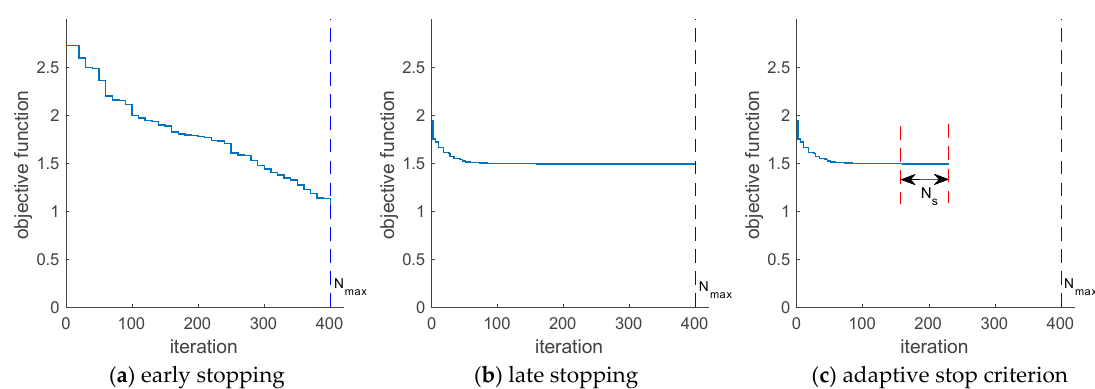
Figure 9. Effectiveness of the adaptive stop criterion for objective functions to be minimized. N max : fixed maximum number of iterations. N s : number of successive iterations without objective function improvements.